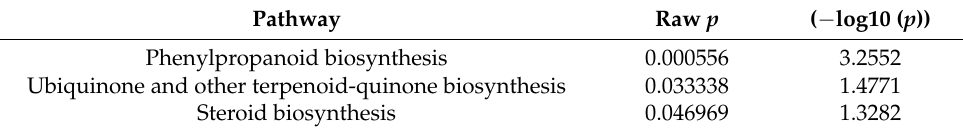
Table 3. Major pathways discriminating the grain metabolome of Mappillai Samba and CBMAS 14065.